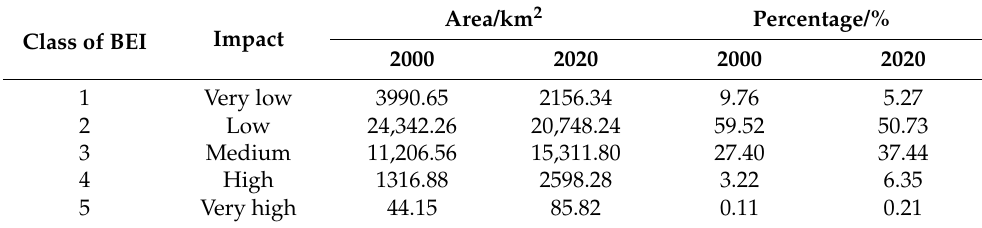
Table 6. Results of BEI classification for the Three Parallel Rivers Natural World Heritage Site.